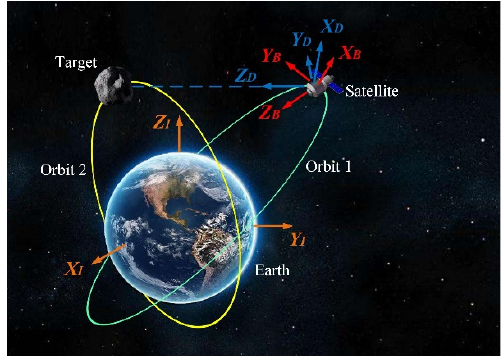
Figure 2. Three-axis frames for spacecraft attitude determination.